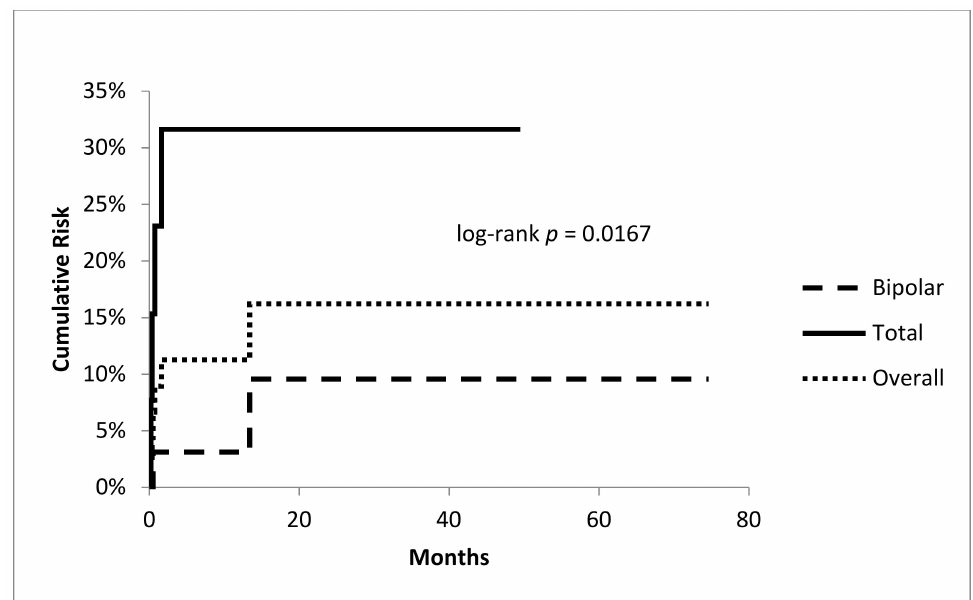
Figure 3. Cumulative risk of dislocation: overall rate and comparison between bipolar vs. total arthroplasties.